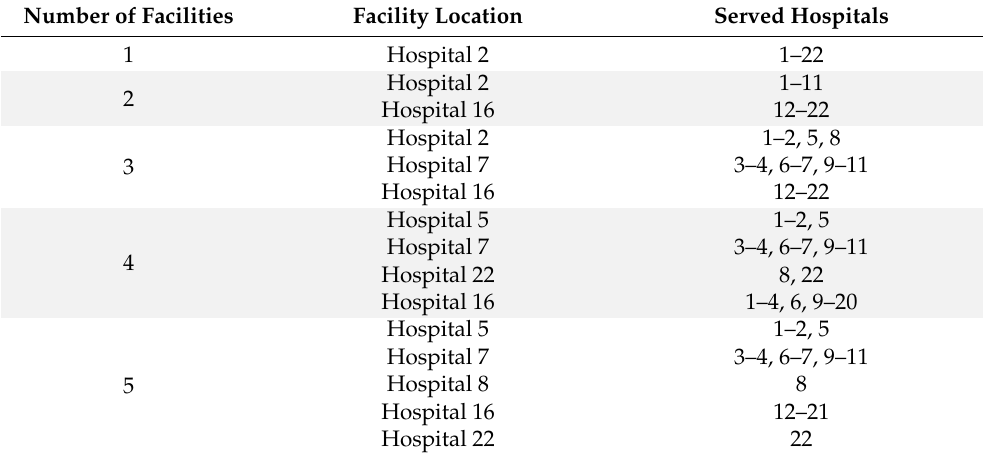
Table 5. Optimum locations of mask manufacturing facilities for different distributed manufacturing